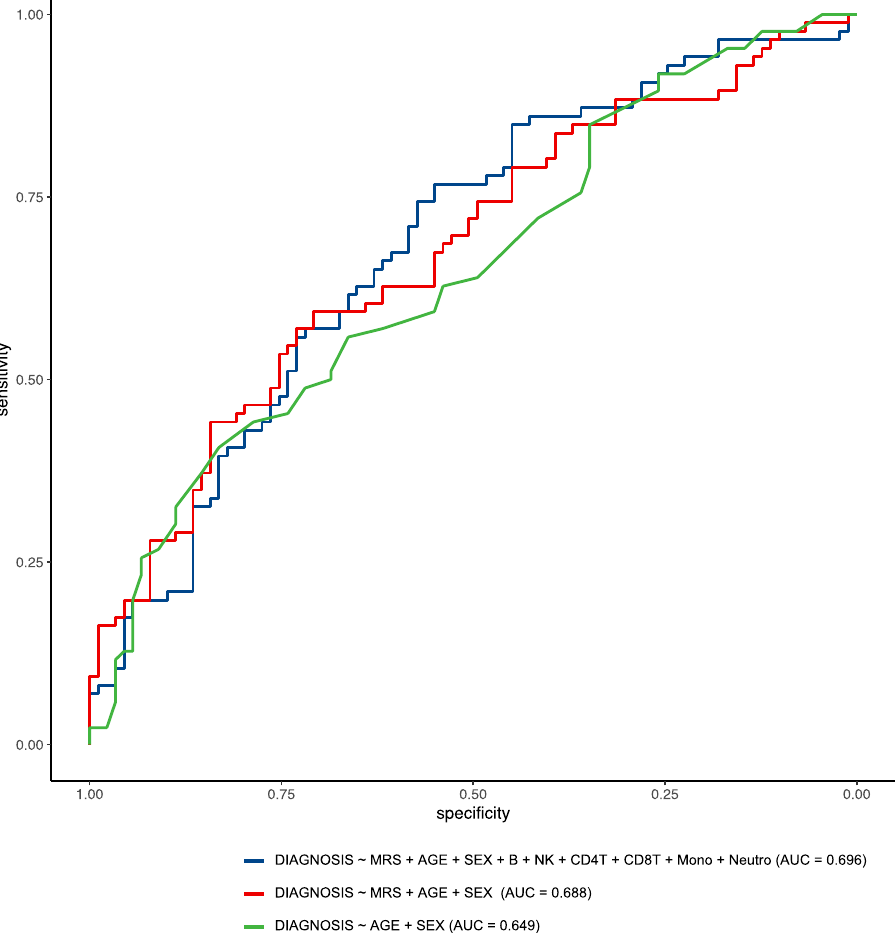
Fig. 4 | Receiver Operating Characteristic curves (ROCs) for logistic regression models predicting AD diagnosis in out-of-sample validation using the AddNeuroMed dataset (83 AD cases and 88 controls). The training dataset included 135 AD cases and 356 control samples from the AIBL dataset. The